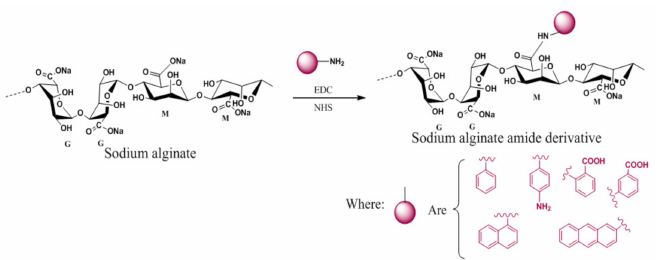
Figure 5. Chemical modification of sodium alginate for the formation of a thixotropic hydrogel.